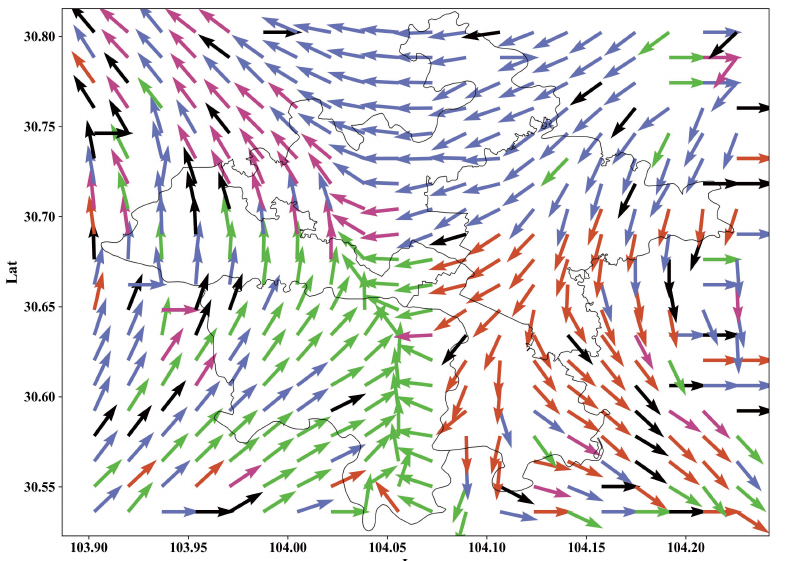
Figure 9. Traffic flow network direction vector field and scale-free characteristics. (Arrows represent the Origin-Destination (OD) direction of different grids, arrows of different colors represent different communities, the largest four communities are represented with the same colors as Figure 8, and the rest of the communities are represented in